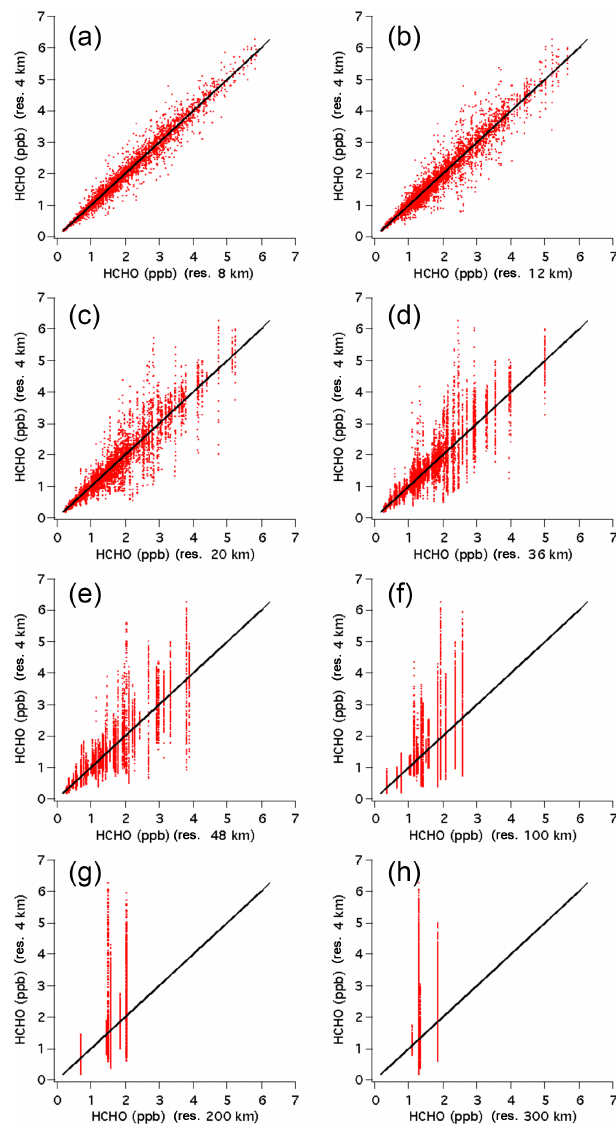
Figure 7. Comparison of HCHO mixing ratios at 4km × 4km reso- lution with mixing ratios at coarser resolutions of (a) 8km × 8km, (b) 12km × 12km, (c) 20km × 20km, (d) 36km × 36km, (e) 48km × 48km, (f) 100km × 100 km, (g) 200km × 200km, and (h) 300km × 300km. The one-to-one line is shown in black.